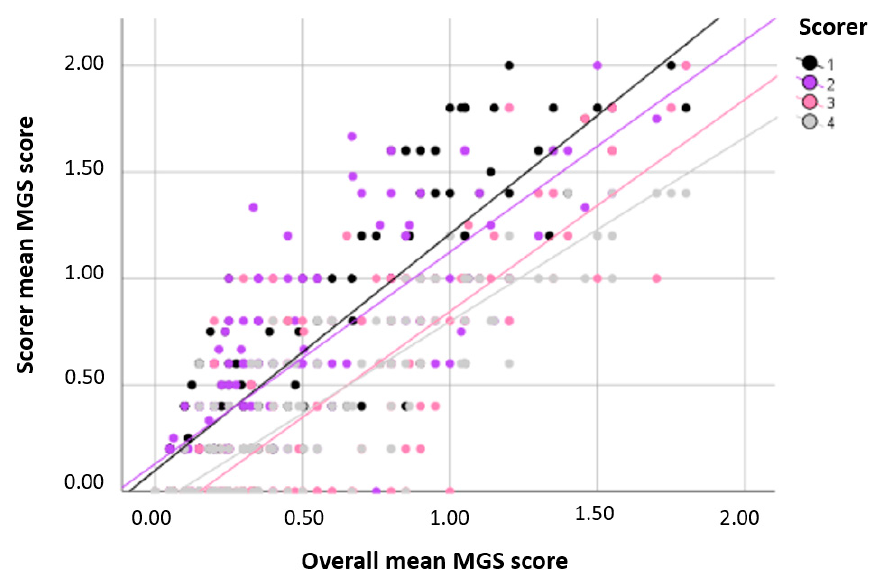
Figure 2. Reliability analysis of the mean MGS scores. The mean MGS scores of each of the four scorers were compared to the mean MGS scores of all scorers. Three scores for each mouse were included in the analysis (i.e., one score each was obtained from images generated at baseline, 150 min, and two days after anesthesia). Abbreviation: Mouse Grimace Scale (MGS).